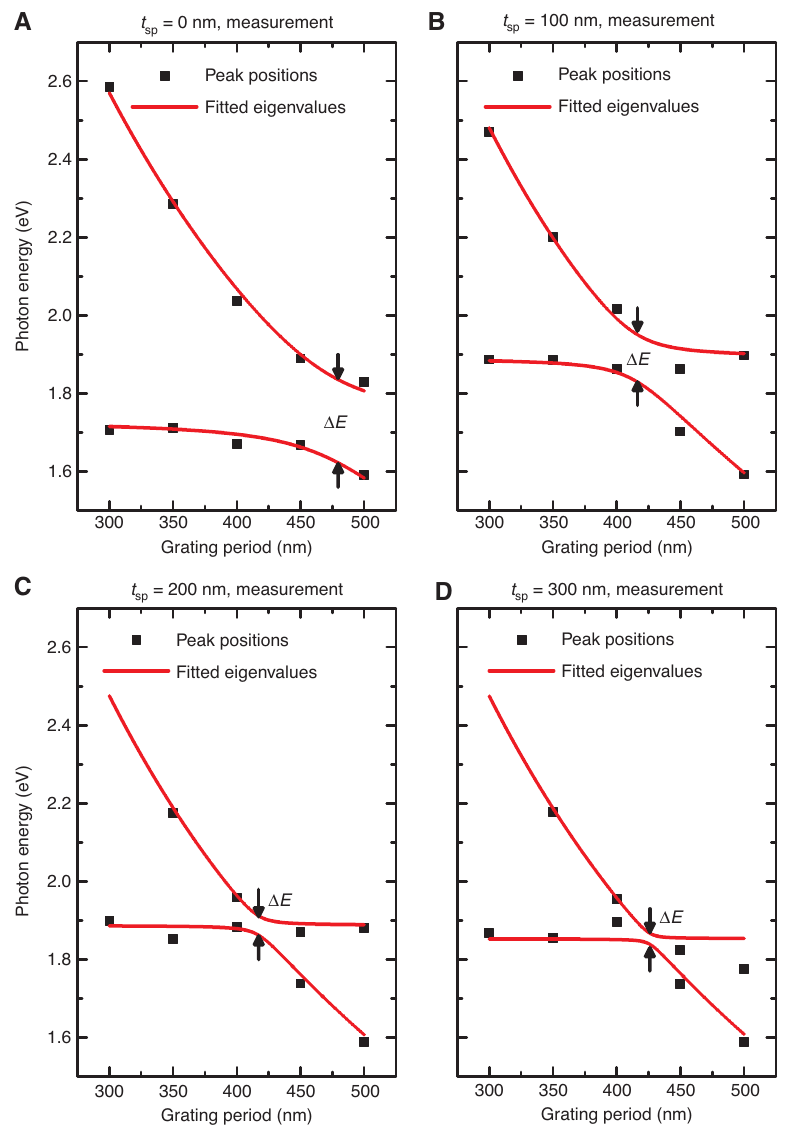
Figure 3: Coupling strength behavior for different spacer layer thicknesses. Energy positions of the extinction maxima versus grating period d extracted from the measured spectra (black squares) for (A) t x = 100 nm, (C) t = 200 nm, and (D) t = 300 nm. Red lines correspond to the fitted eigenvalues of the effective energy matrix [Equation t sp sp sp The polariton splitting thus obtained is depicted in Figure 4B for an exemplary spacer layer thickness of = 200 nm. For the thickness and the refractive indices, as a function of spacer layer thickness in Figure 4A t sp (left scale) with the black squares corresponding to the the parameters given in Methods for the scattering measured data and the red circles to the simulated data. matrix calculations are used. The propagation constant β The normalized electric field amplitude | E | of a trans- was assumed to possess the value β x p verse magnetic waveguide mode (see inset) is plotted in A similar behavior of the polariton splitting (circles and this figure versus the corresponding spacer layer thick- squares) and the electric field amplitude (green line) ness as the green solid line (right scale). To calculate E can be recognized in Figure 4A. The agreement between , x the simulated data and the electric field amplitude is an undisturbed waveguide slab without grating coupler particularly good. The deviations of the measured split- sandwiched between a cover and a substrate layer is ting to the simulations might be due to slightly different assumed with the electric field decaying exponentially spacer layer thicknesses or sample imperfections. This in the two surrounding layers. The vertical dependence good agreement between the behavior of the polariton of the field amplitude E as a function of z is depicted x